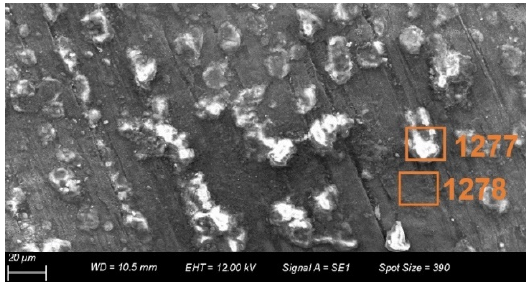
Figure 17. Points analyzed in the fixed contact of Figure 6b, in the “Cut Y” zone.